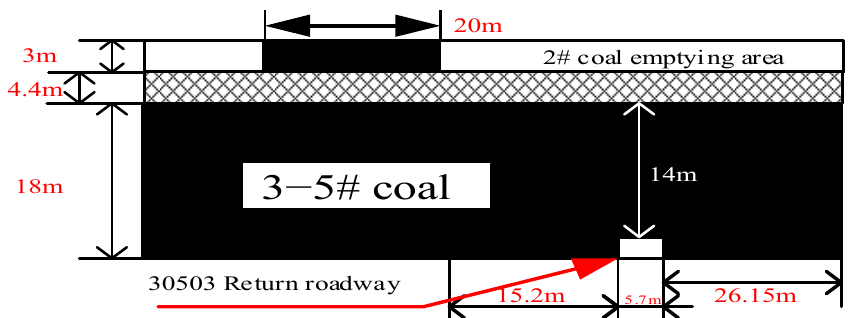
Figure 1. Diagram of the layout of the roadway between coal seams #3–5 and #2.